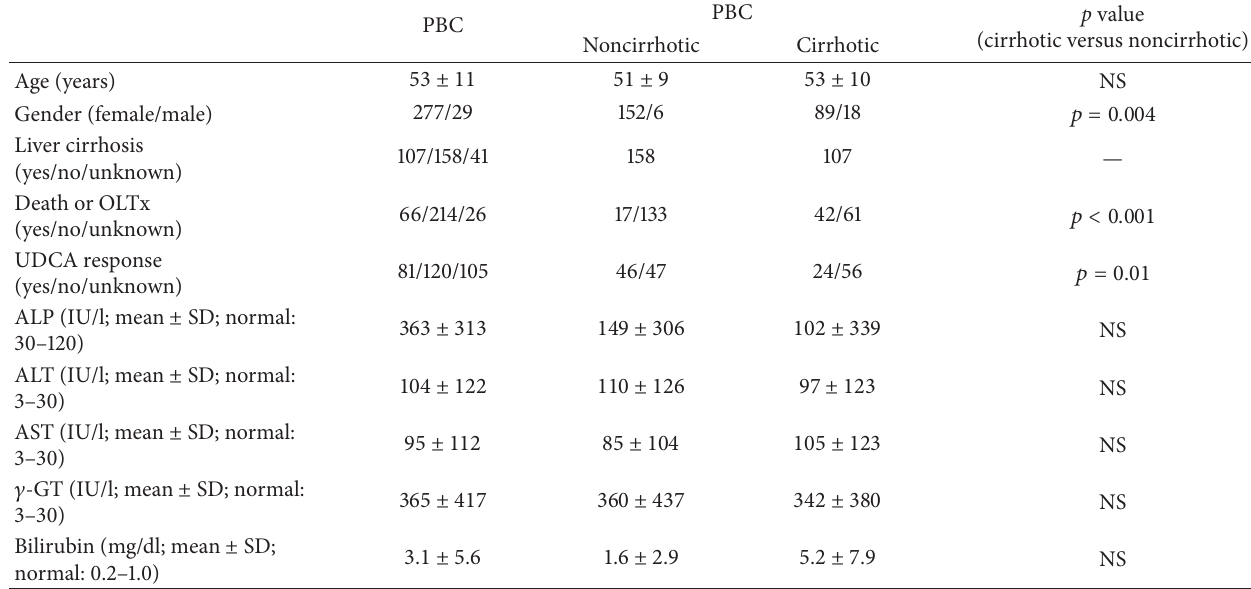
Table 1: Clinical and laboratory data in patients with primary biliary cholangitis (PBC).